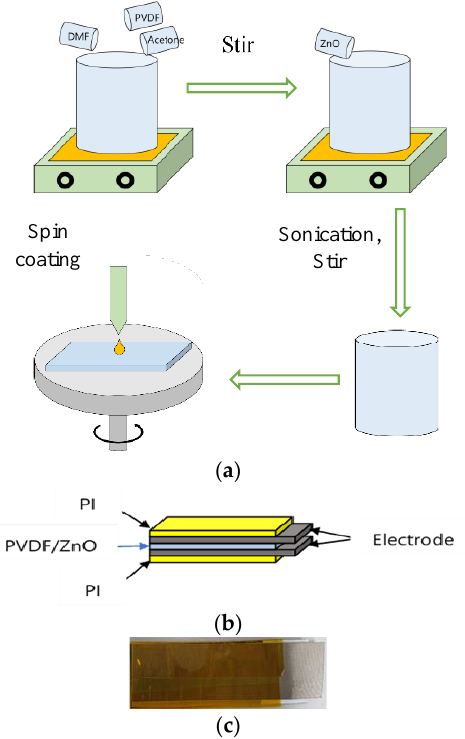
Figure 2. ( a ) Composite and film preparation process, ( b ) PNG design, ( c ) fabricated PNG.